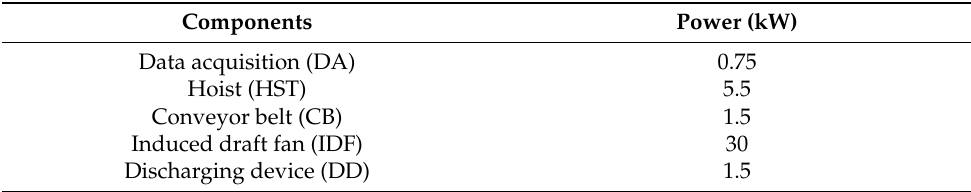
Table 1. The details of the electrical components adopted in this work.